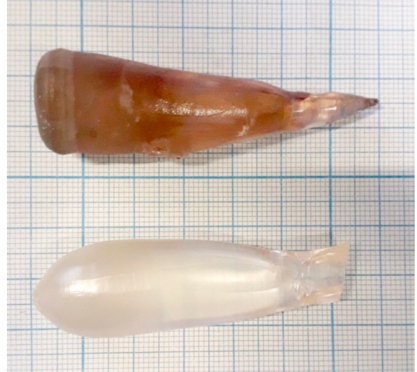
Figure 4. Photos of the grown crystals: the crystal-etalon ( top ) and the “pure” crystal grown from the purified ZnO and WO 3 chemicals ( bottom